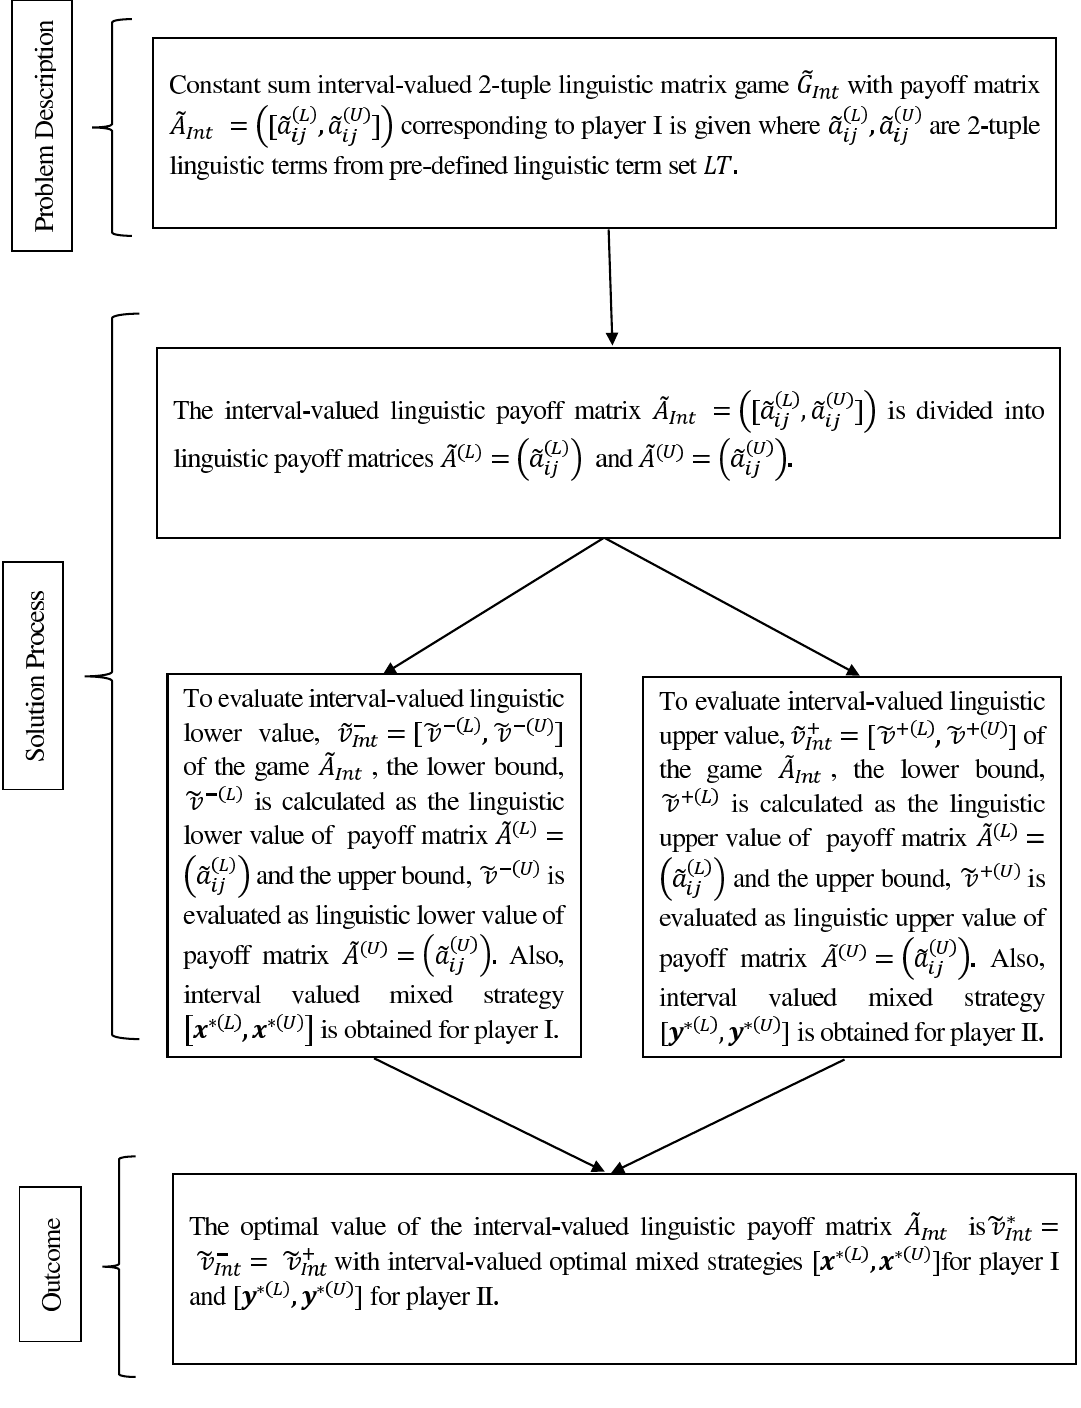
Figure 1. Proposed methodology Figure 1. Proposed Figure 1. Proposed Methodology